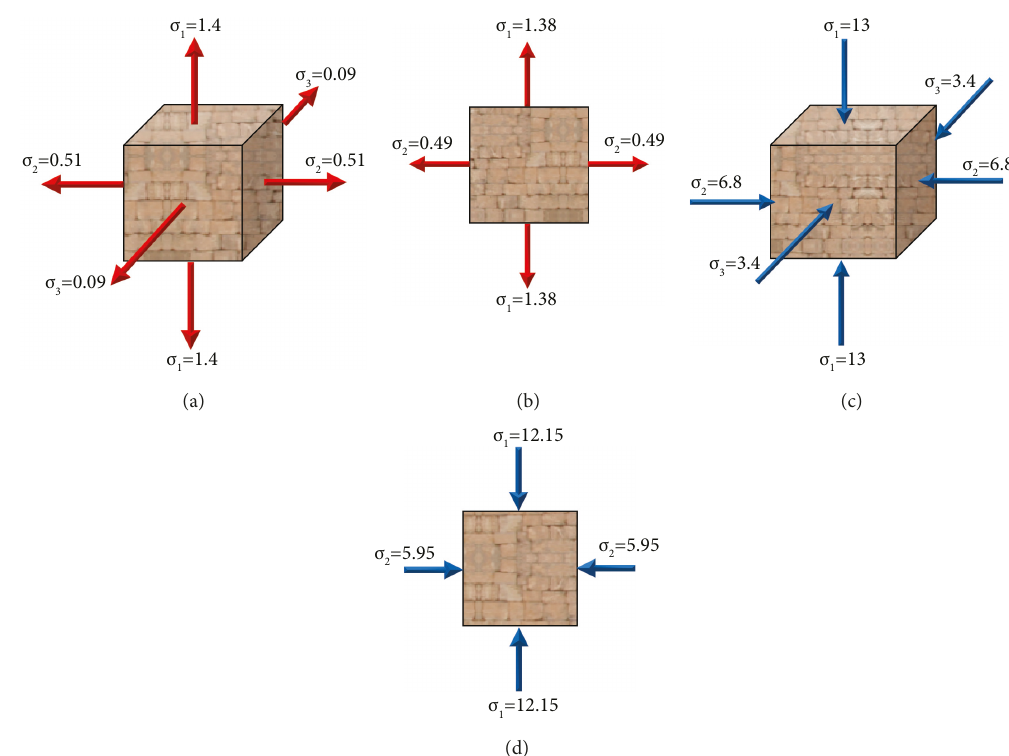
Figure 8: (a) Maximum 3D principal stress. (b) 2D equivalent maximum principal stresses. (c) Minimum 3D principal stress. (d) 2D equivalent minimum principal stresses.